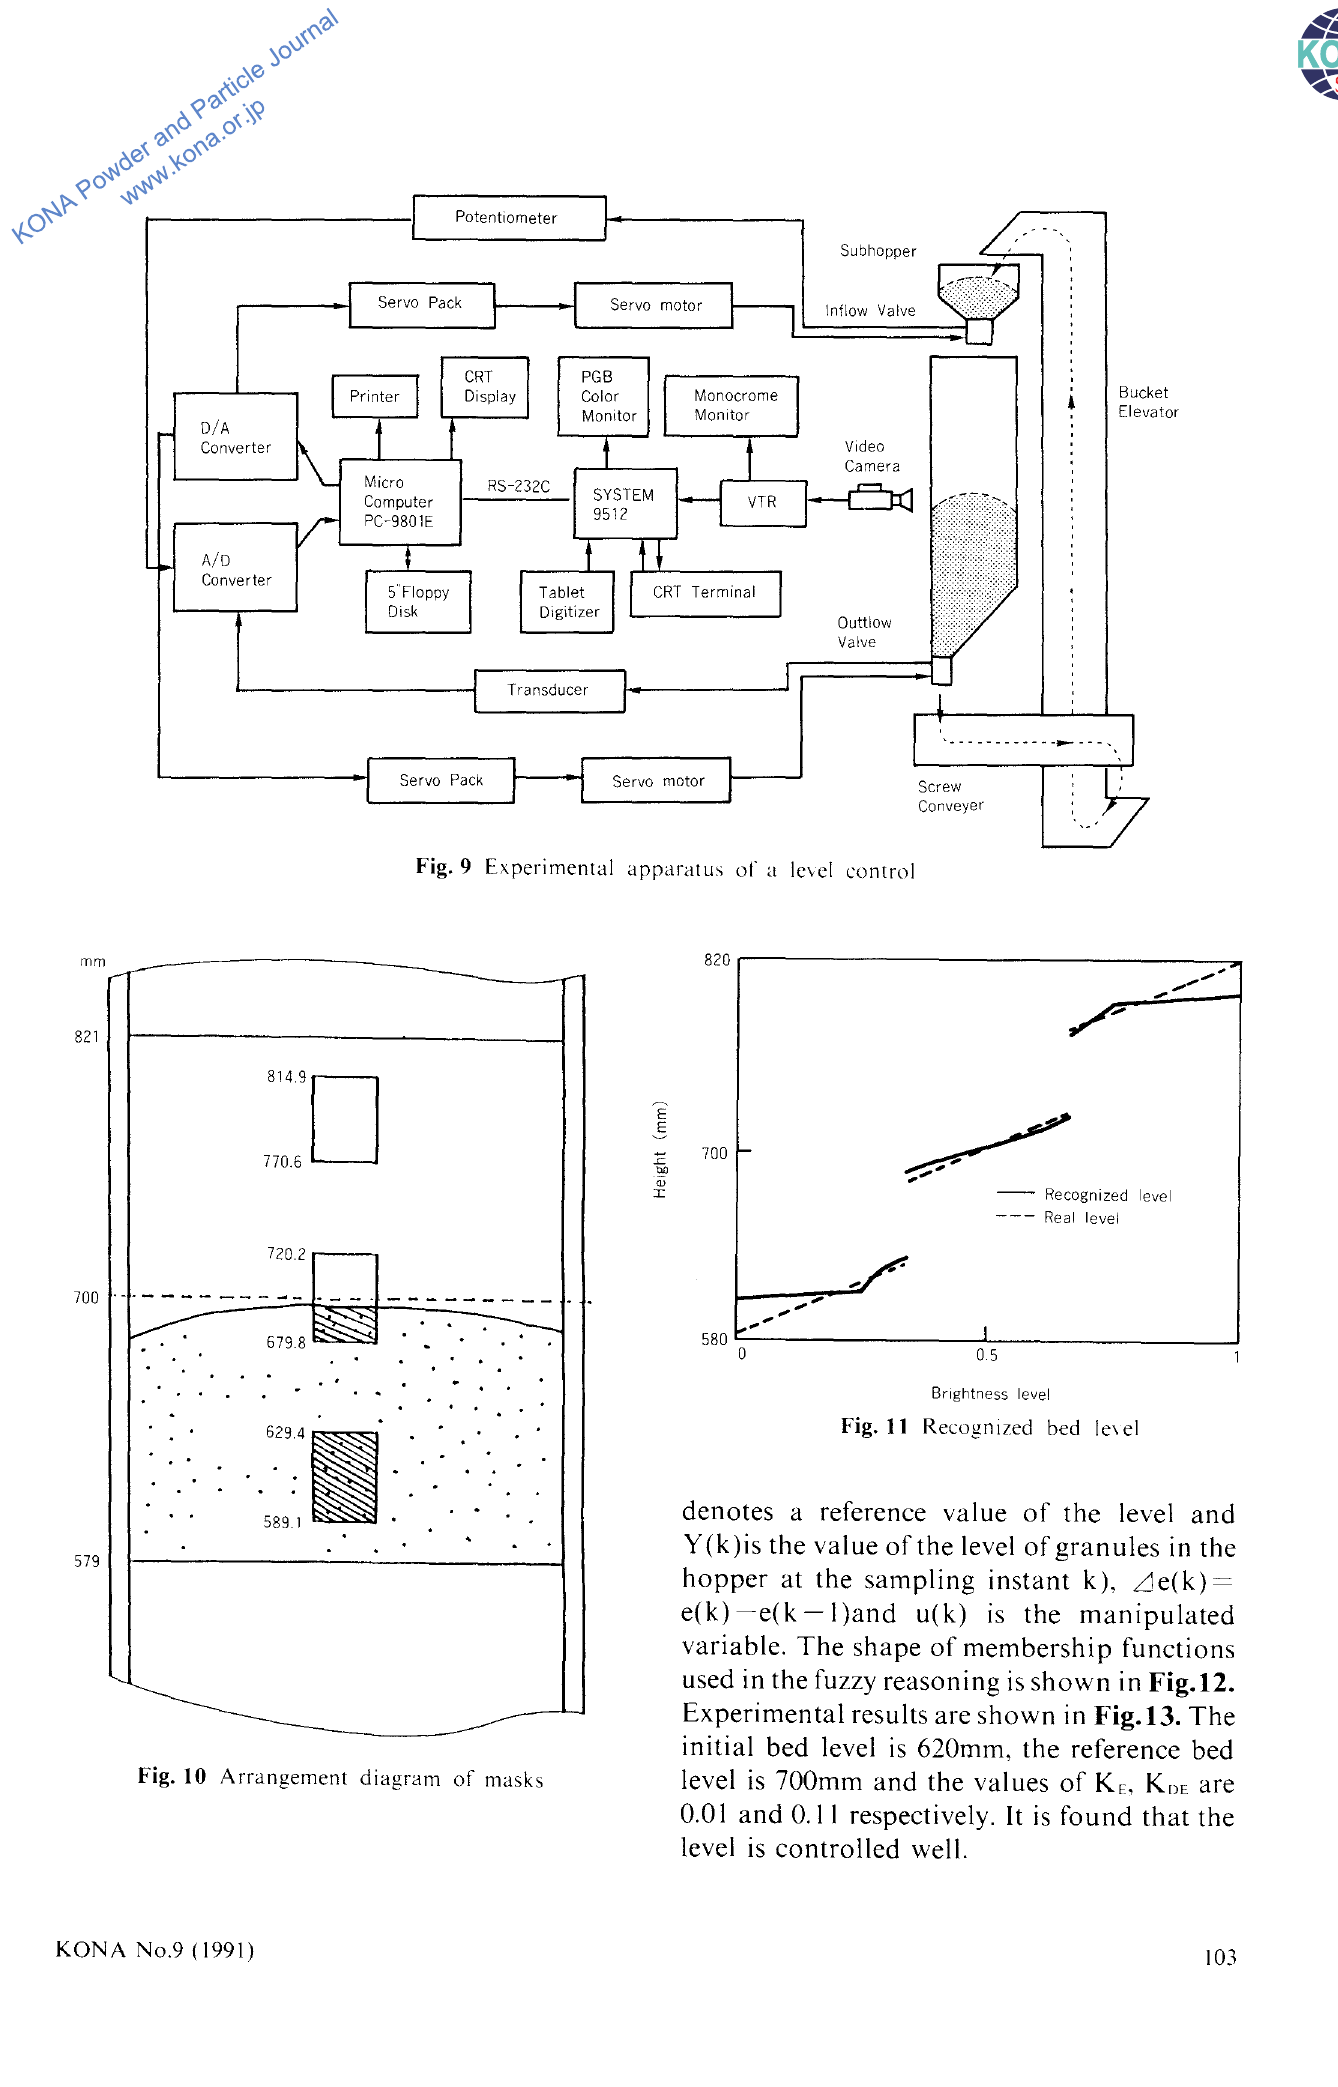
Fig. 10 Arrangement diagram of masks